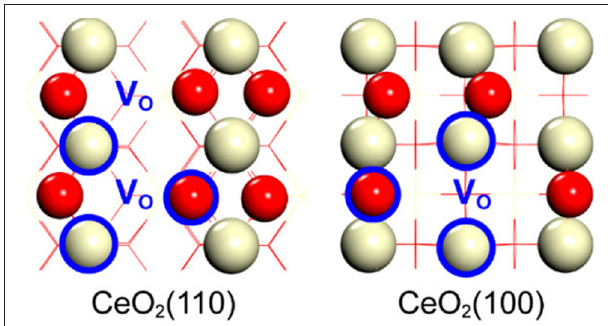
FIGURE 3 | Schematic of solid FLPs on CeO 2 (110) and CeO 2 (100) constructed by surface oxygen vacancy regulation. White and red balls represent Ce and O atoms, respectively. Atoms labeled by blue circles represent the Lewis acid (Ce) or Lewis base (O) of solid FLPs. The position of oxygen vacancy is labeled by V O in blue (Huang et al., 2018, Reprinted with permission from American Chemical Society).